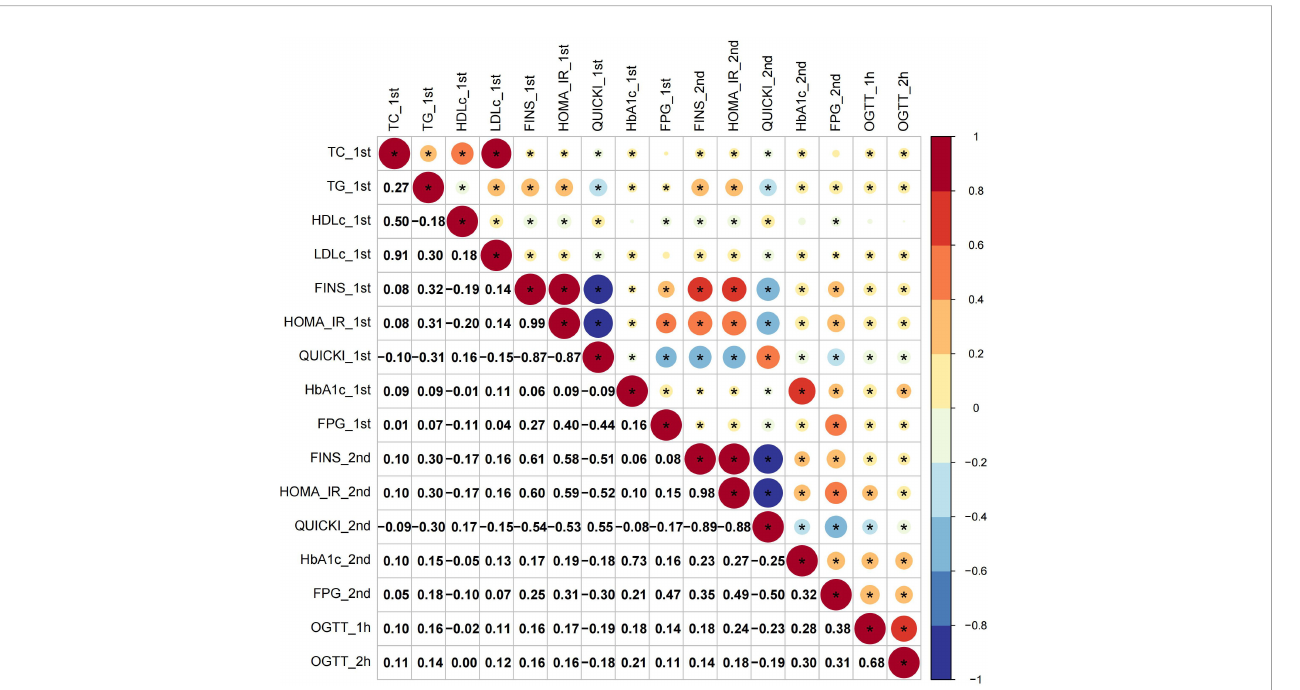
FIGURE 1 Correlations of fi rst-trimester lipid pro fi les with glucose metabolism and insulin indices. Asterisk (*) in the circles denoted P < 0.05; _1st and _2nd denoted fi rst and second trimester, respectively.